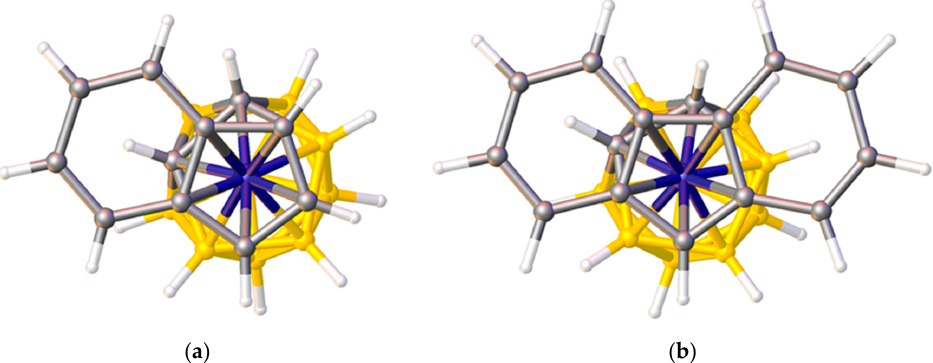
Figure 8. ( a ) The structure of [3-(C 9 H 7 )- closo -3,1,2-CoC 2 B 9 H 11 ] in plan view; ( b ) The structure of [3-(C 13 H 9 )- closo -3,1,2-CoC 2 B 9 H 11 ] in similar view. In both structures note the cisoid arrangements of ring-junction and carborane C atoms.